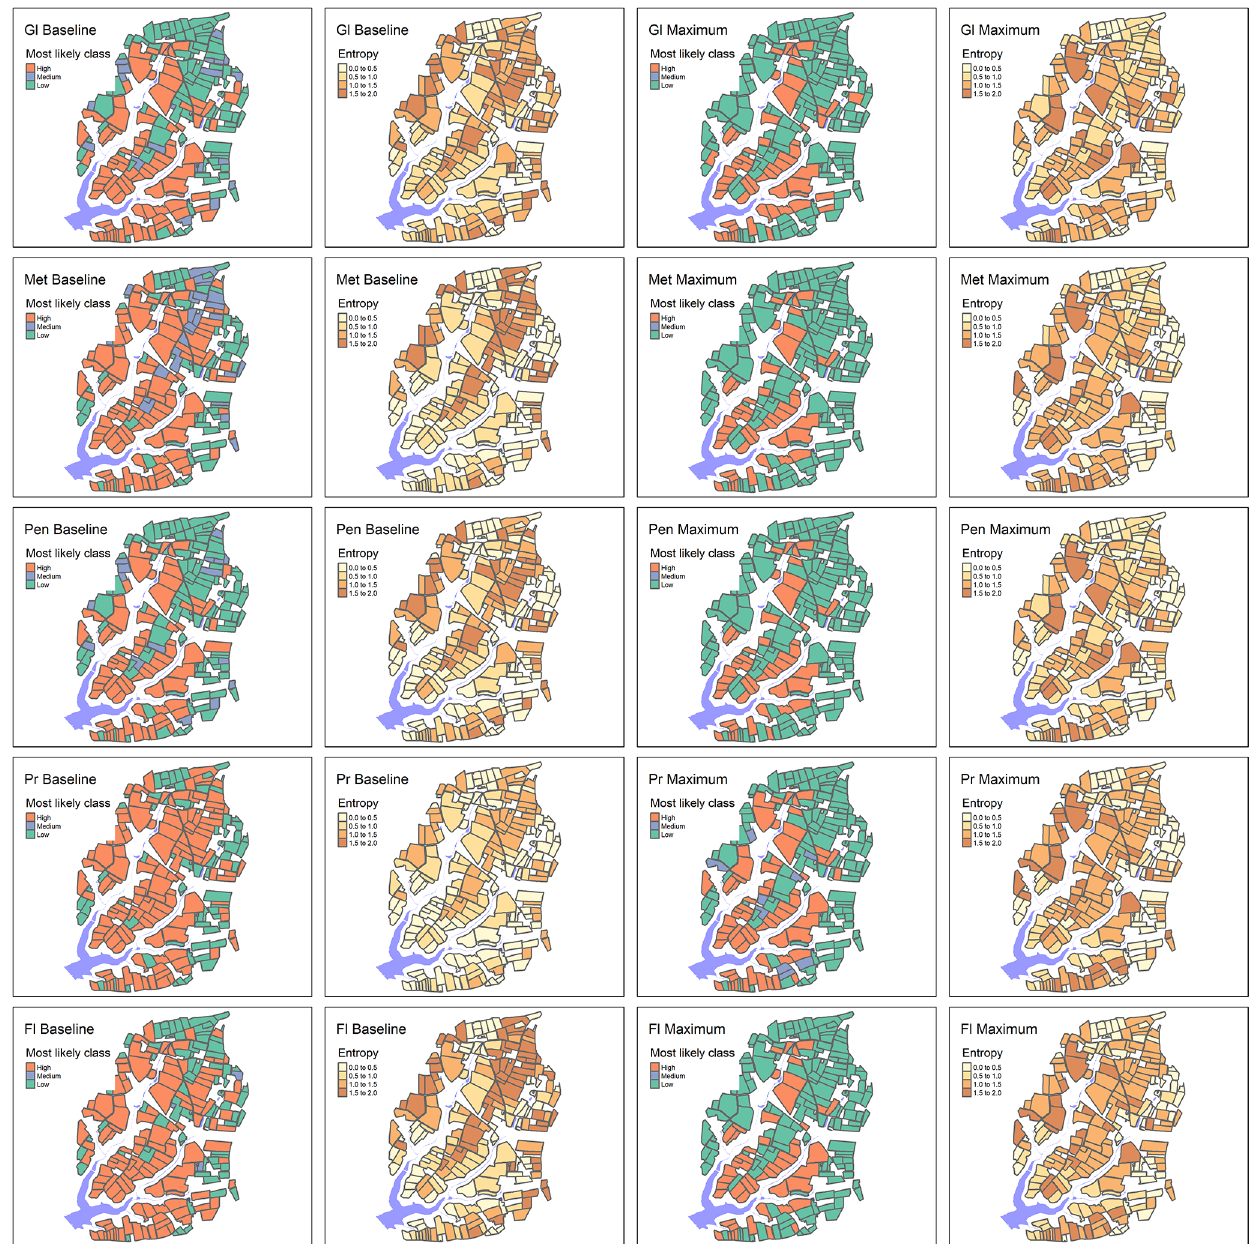
Figure 6. Spatial variability and associated uncertainty (entropy) in the surface water risk under current practices for the five active ingredients under baseline and maximum mitigation scenarios: Gl – glyphosate, Met – metobromuron, Pen – pendimethalin, Pr – prosulfocarb, and Fl –